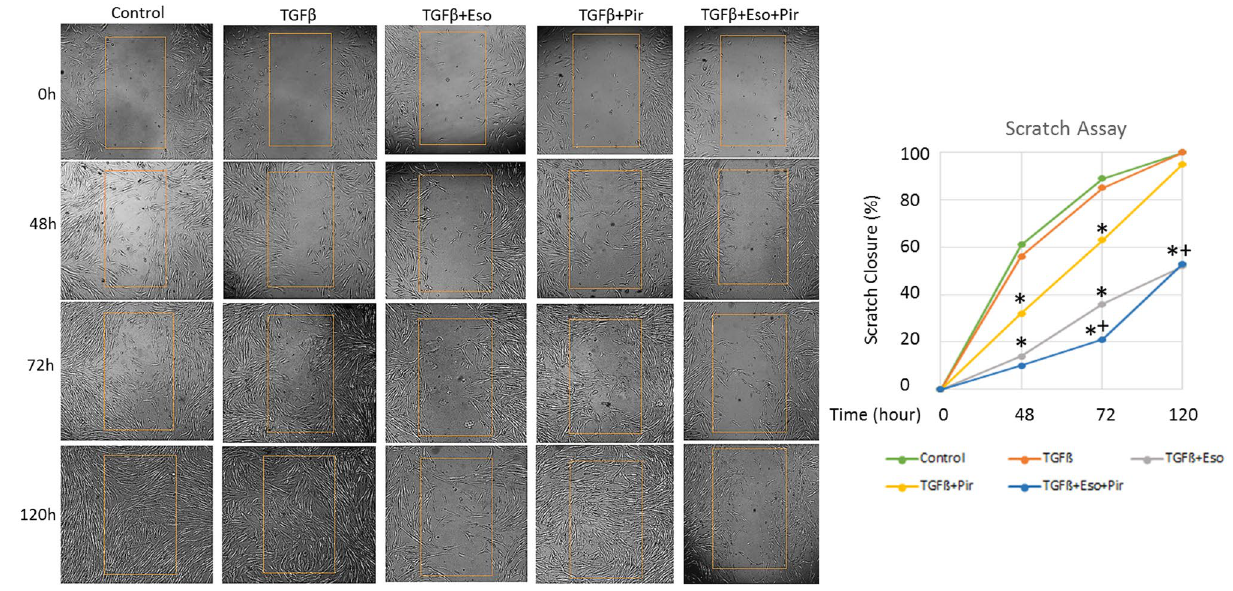
Figure 2. Cell migration assay showing the effect of esomeprazole (Eso), pirfenidone (Pir), and the combination on cell migration. Monolayers of human IPF lung fibroblasts were denuded to create cell-free area prior to stimulation with TGFβ (10 ng/mL) for 48, 72 or 120 h in the absence or presence of esomeprazole (100 µM), pirfenidone (1 mM) or esomeprazole (100 µM) and pirfenidone (1 mM) combination. Cell migration to close the denuded area, shown as averaged percentage of scratch closure, was quantified for comparison. Data represents three independent experiments. *p < 0.05 vs TGFβ only control and + p < 0.05 vs pirfenidone alone